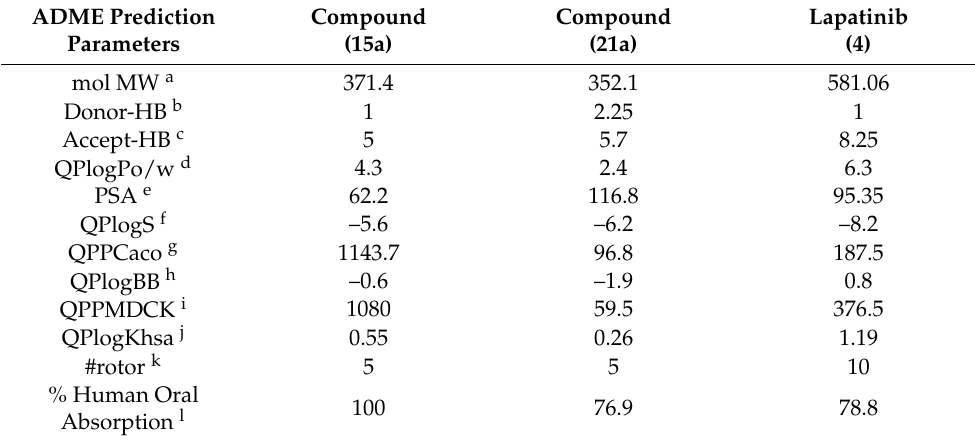
Table 3. In Silico ADME prediction parameters of designed and reference